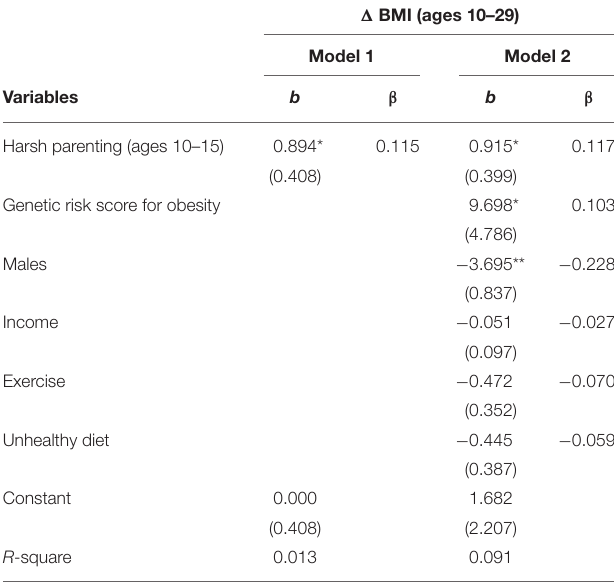
TABLE 2 | Regression models examining harsh parenting as a predictor of change in body mass index ( N =